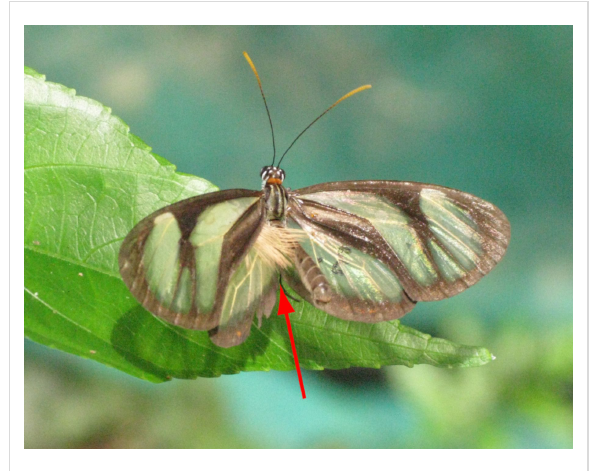
Figure 1: Extended hairs (arrow) of the androconia of a male Ithomia salapia aquinia (Photo: Melanie McClure).